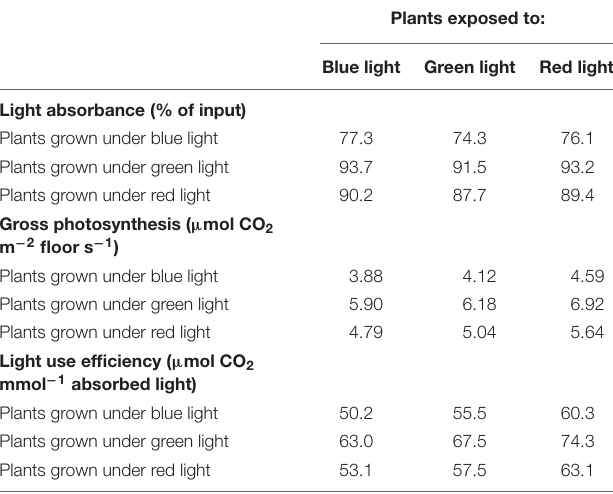
TABLE 6 | Modeled light absorbance, gross photosynthesis and light use efficiency of a tomato crop.